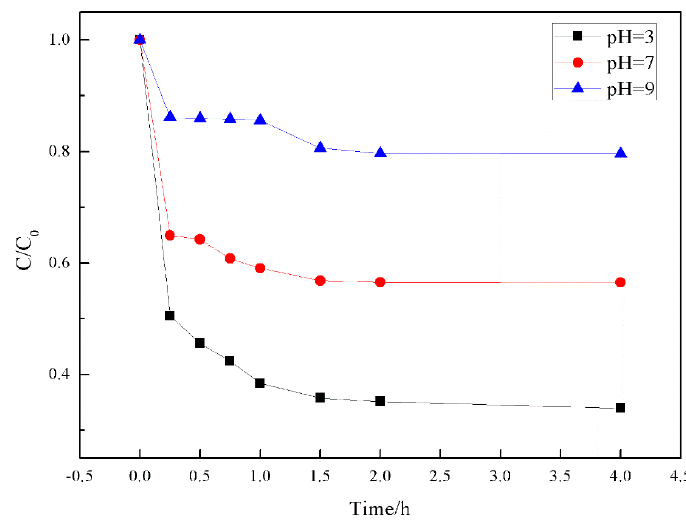
Figure 11. Effect of pH on the degradation of methyl orange by STCF.